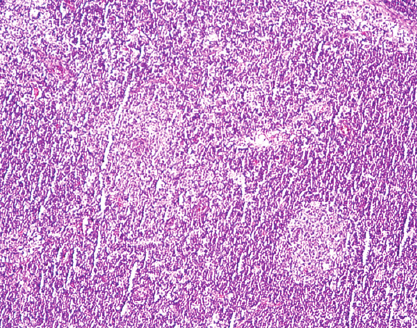
Figure 2: Lymph node showing reactive germinal centers and expanded paracortical areas suggestive of Kikuchi Fujimoto disease.